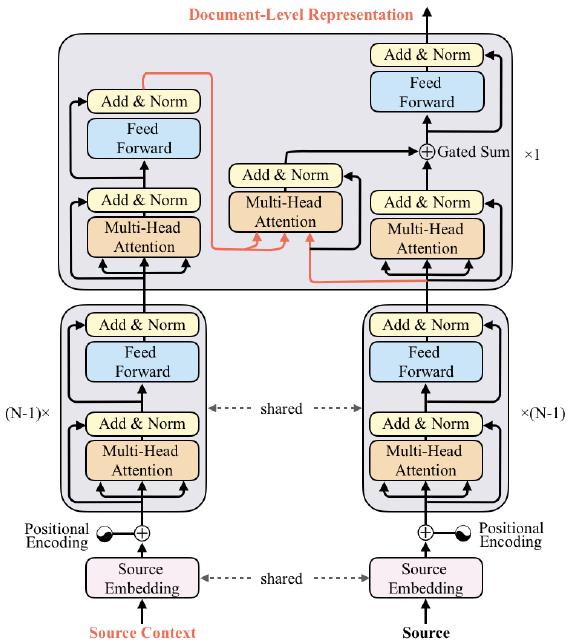
Figure 5. The architecture of the document-level Transformer